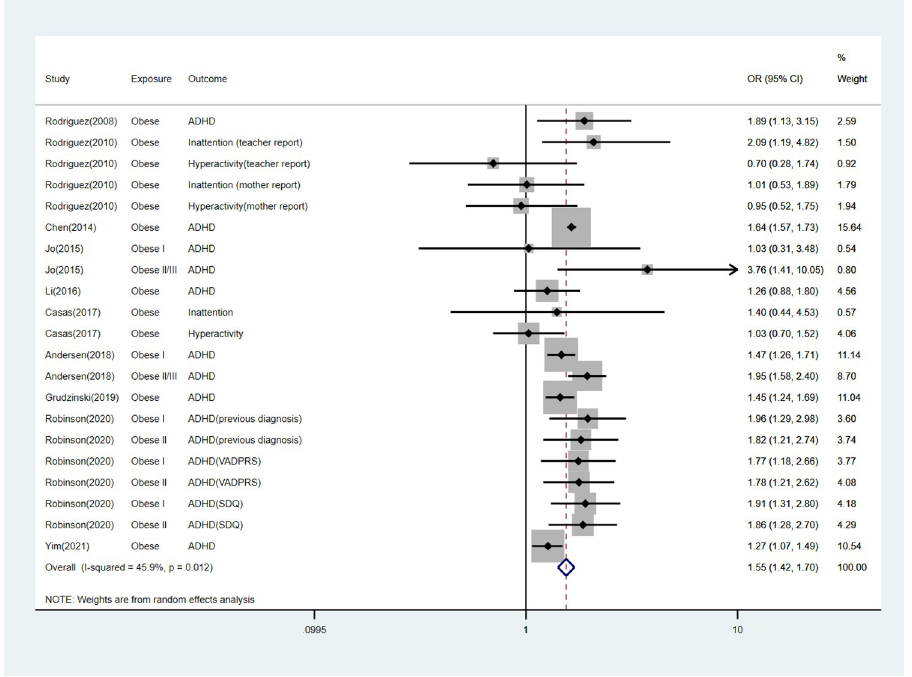
Fig 3. Forest plot for obese mothers and their offspring’s risk of ADHD.